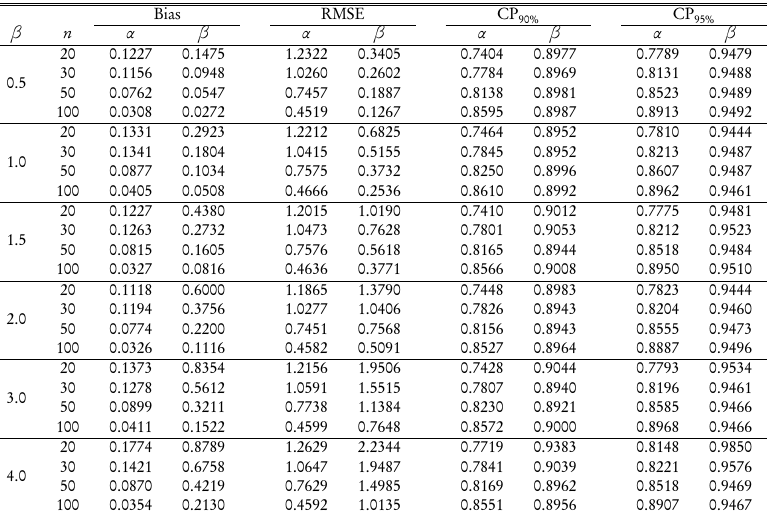
Estimated bias, root mean-squared and coverage probability α and β ( α = 1.0